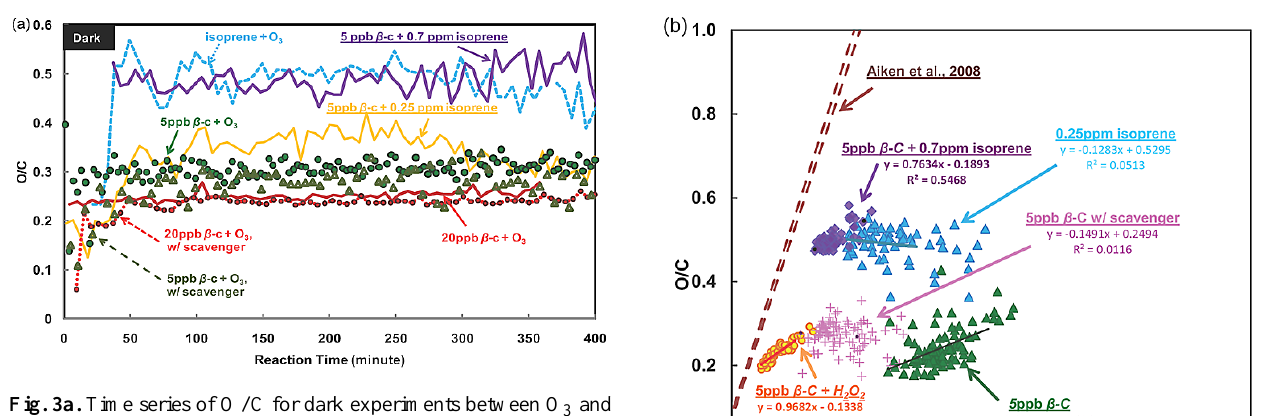
Fig. 3a. Time series of O/C for dark experiments between O 3 and β -C/ isoprene. No OH scavenger was present in the reaction unless specified.